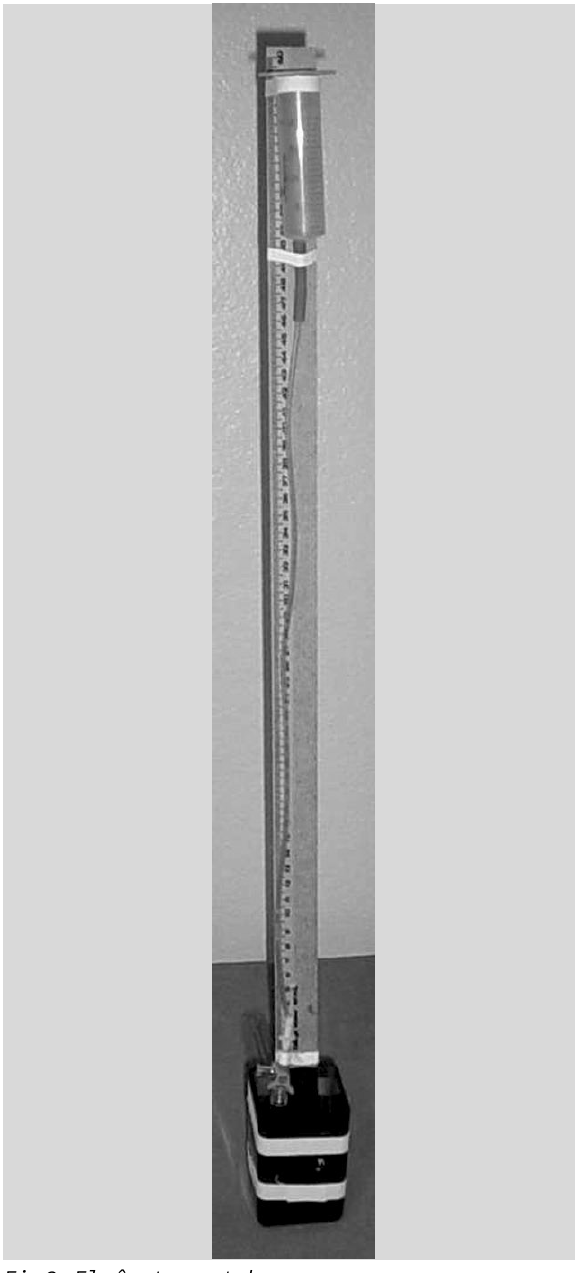
Fig. 3 - Fluxômetro